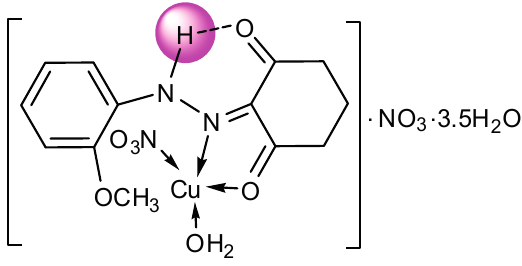
Figure 3. Structure of [Cu(L 1 )(NO 3 )H 2 O]NO 3 ·3.5H 2 O complex.